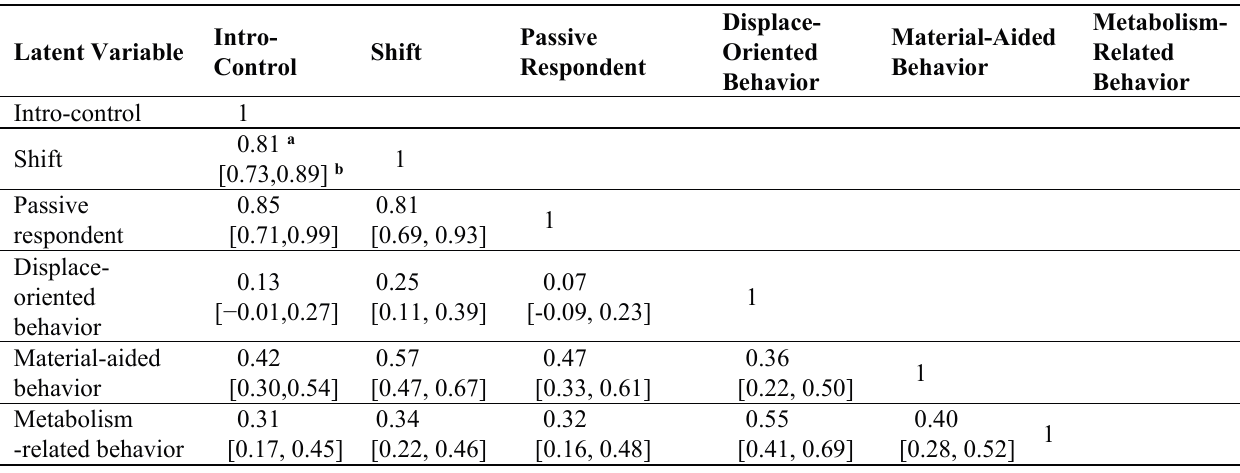
Table A4. Discriminant validity of thermal adaptation strategies.